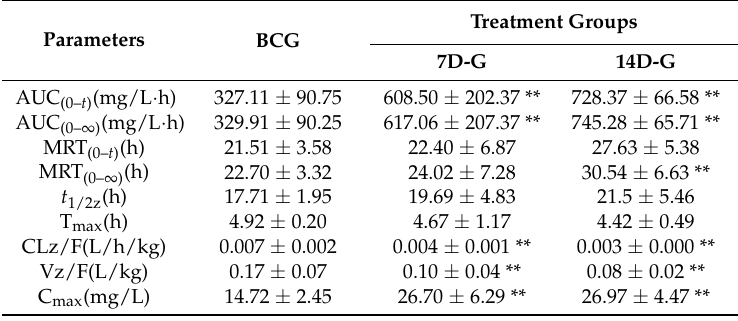
Table 7. Effects of SGI on pharmacokinetic parameter of warfarin (2.0